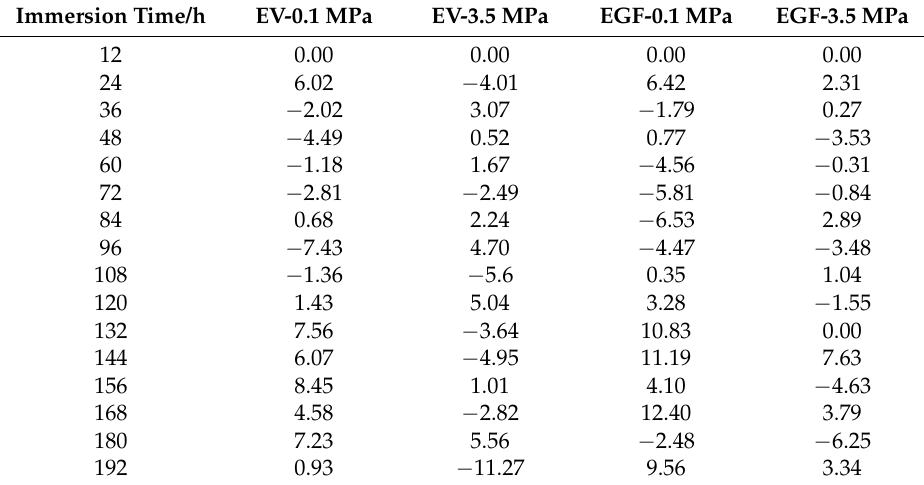
Table 3. The relative errors of the established GM (1, 1) grey models for the coatings under different